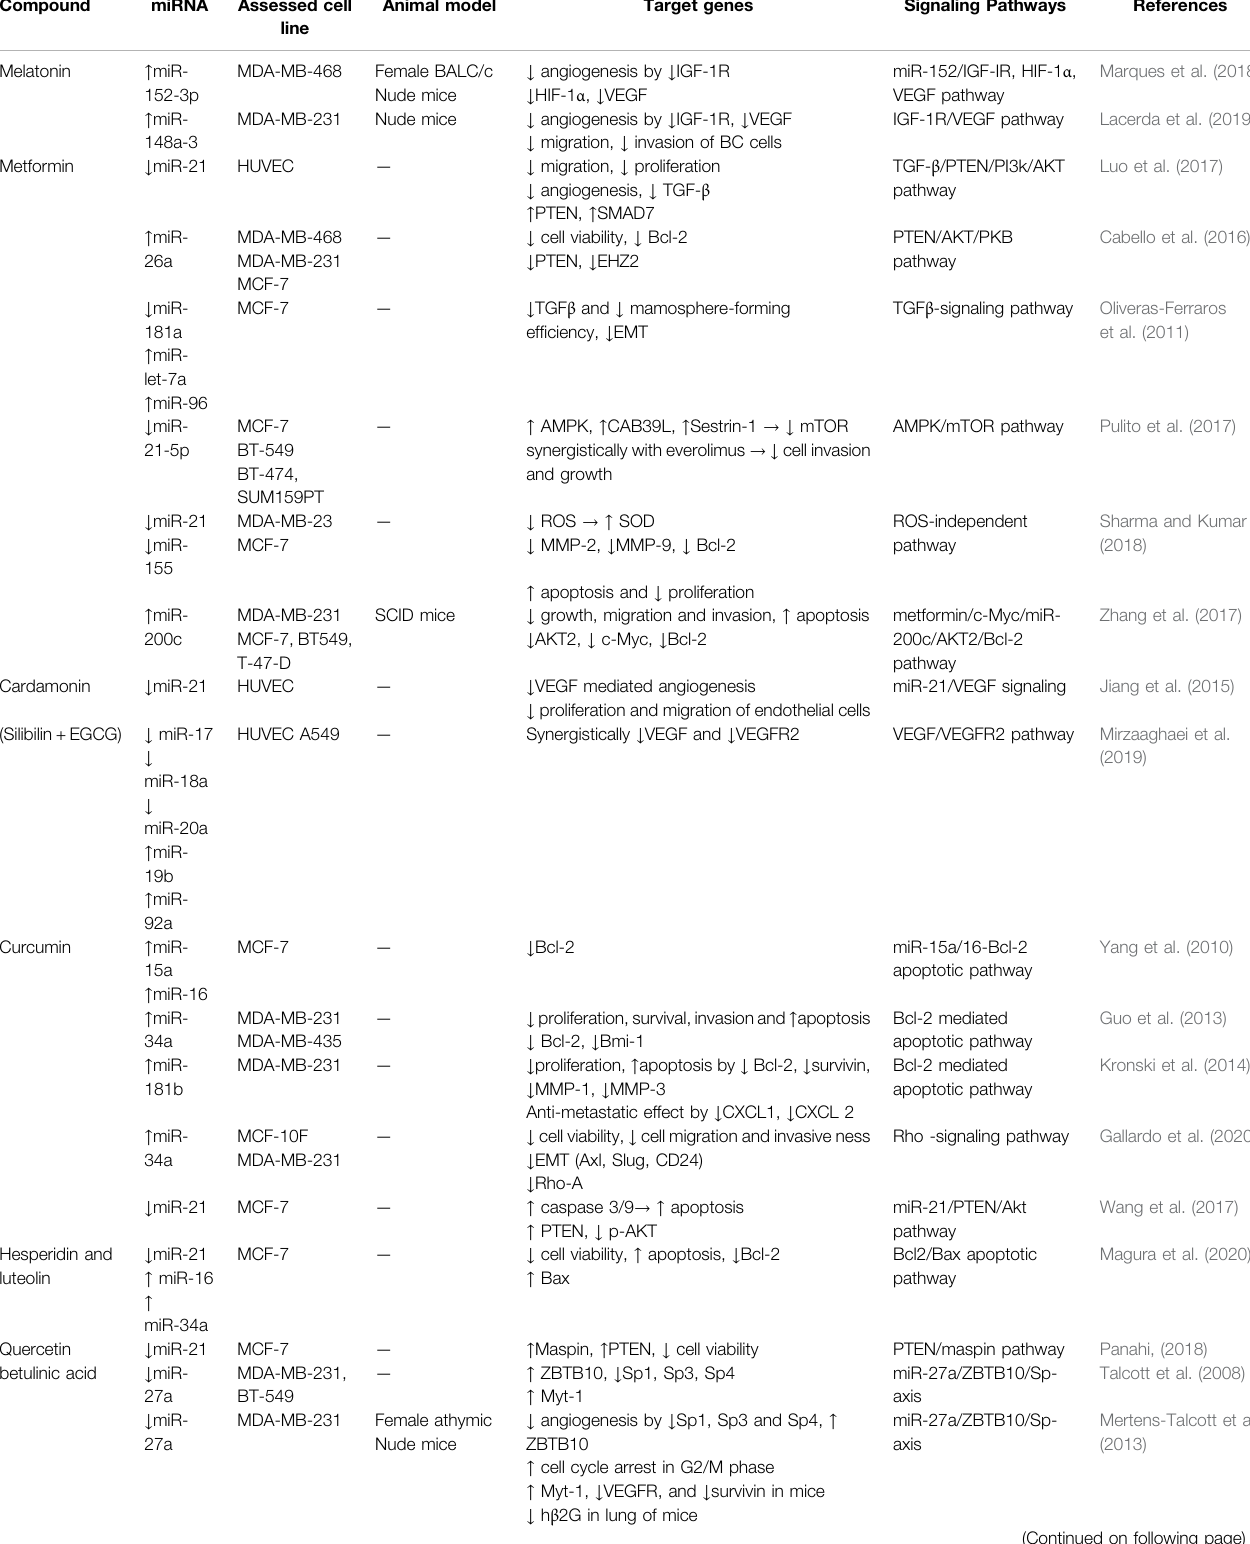
TABLE 3 | Phytochemicals and their target miRNAs regulating tumor angiogenesis.